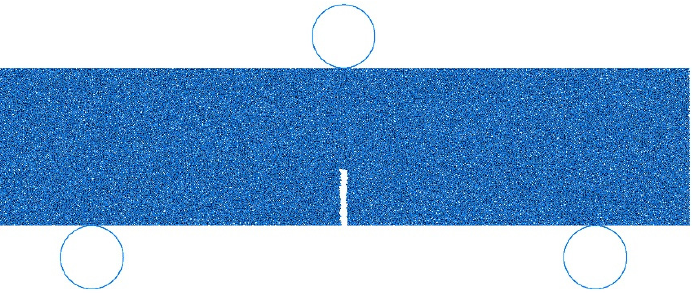
Figure 14. A DEM model for three-point bending test.